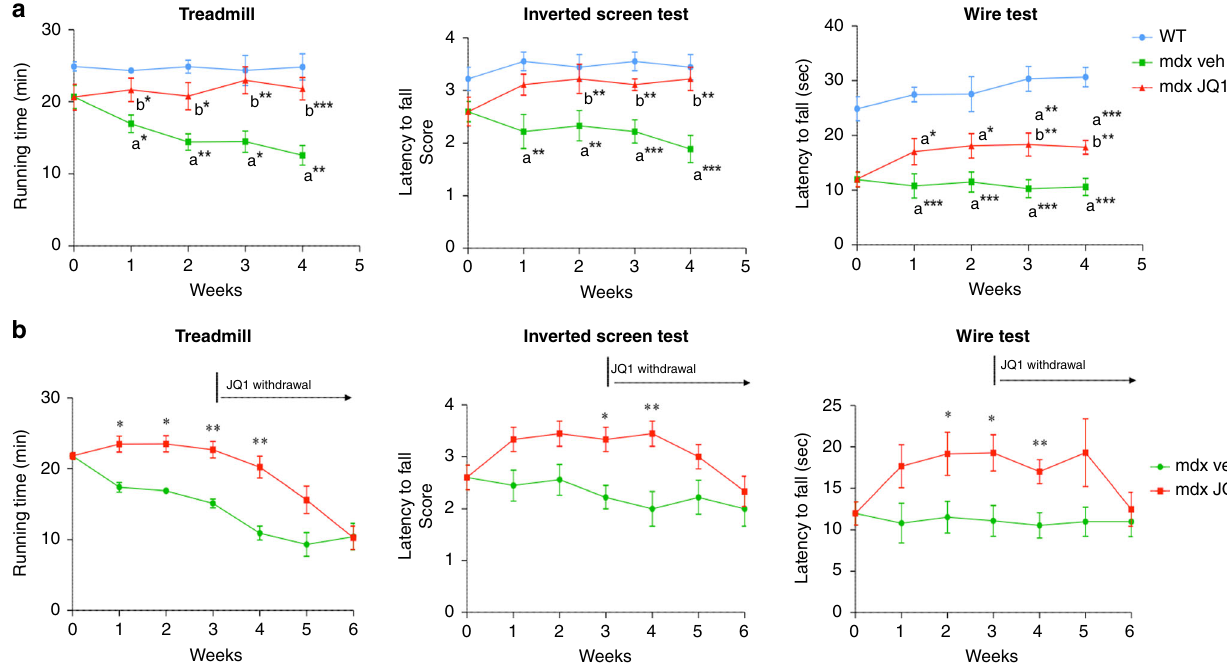
Fig. 7 Functional amelioration mediated by JQ1 persists following withdrawal. a Treadmill (WT: n = 3; mdx veh: n ≥ 7; mdx JQ1: n ≥ 8), inverted screen ( n = 9 for each experimental group) and wire (wt animals: n = 9; mdx mice: n = 18 for each group) tests were performed on control, vehicle- and mdx- treated mice. Data are expressed as the mean ± SEM). * P < 0.05, ** P < 0.01 and *** P < 0.001 were determined by one-way ANOVA followed by Tukey ’ s post hoc test for the treadmill test and with Kruskal – Wallis test followed by Dunns post hoc for wire and inverted screen tests. a indicates statistical signi fi cance compared to Control group; b indicates statistical signi fi cance compared to the mdx mice animal group. b Mice were treated with JQ1 or vehicle for 3 weeks and treadmill ( n = 3 for each experimental group), inverted screen ( n = 9 for each group) and wire ( n ≥ 10 for each group) tests were performed once a week, and for additional 3 weeks after JQ1 withdrawal. Data are expressed as the mean ± SEM. * P < 0.05 and ** P < 0.01 indicate statistical signi fi cance versus mdx-vehicle group, and were determined by one-way ANOVA followed by Tukey ’ s post hoc